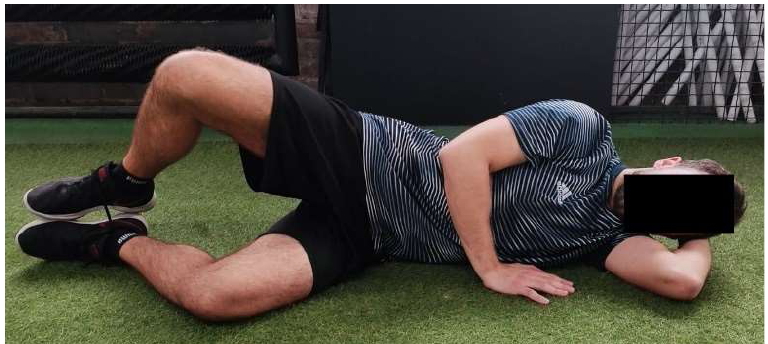
Figure A3. Clamshell (hip clam). Lunge : starting position—standing upright (feet together and facing forward) on a stable surface. For one beat, participants perform a forward lunge with the right leg (the right knee flexed at 90 degrees). Afterwards, by pushing back with the front (right) leg, they return to the starting position (Figure A4). Pelvic drop : starting position—standing on a stable surface with the dominant leg on the edge of a 5 cm box (right side). Participants lower the heel of the non-dominant leg to touch the ground for one beat. Then, they return the foot to the height of the box and keep their knees and hips extended for one beat (Figure